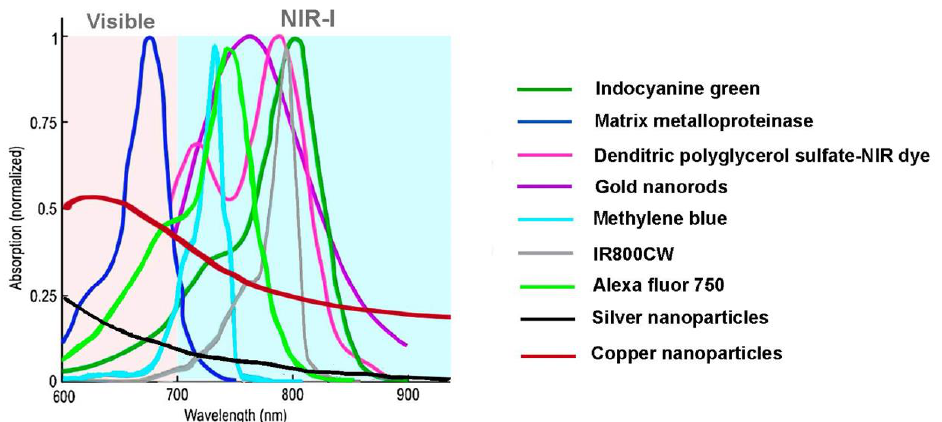
Figure 5. Normalized absorption coefficient versus wavelength for some exogenous contrast agents. Adapted from [23,78,107,108].